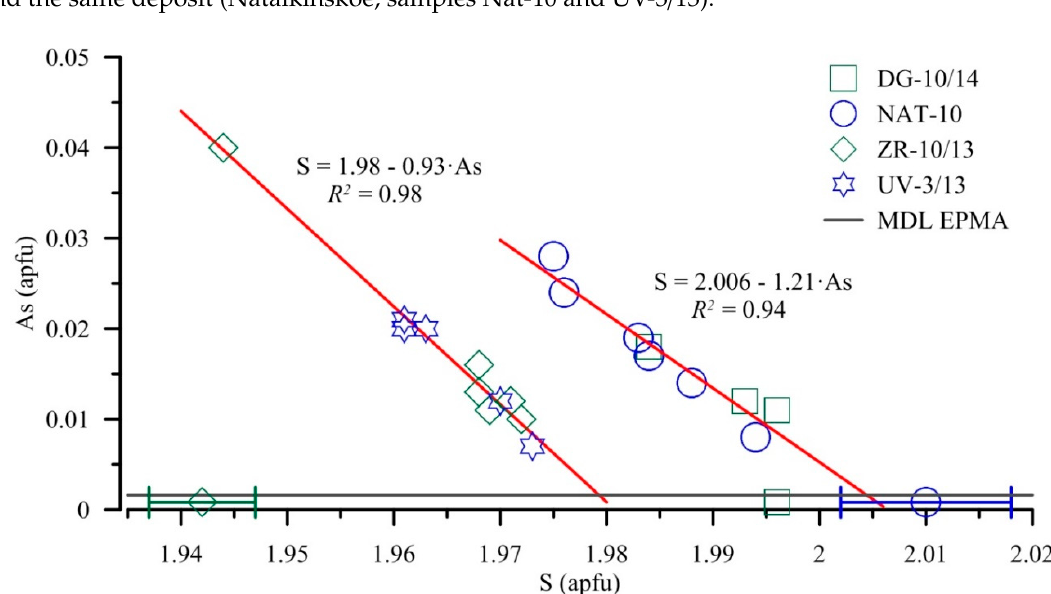
Table 3. Results of the X-ray diffraction study of arsenopyrite and pyrite crystals.